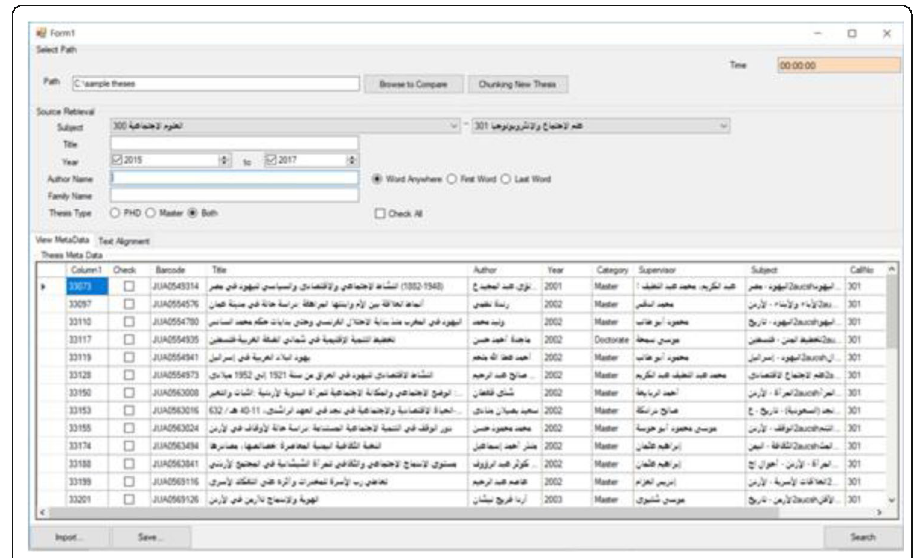
Fig. 5 Graphical user interface of the PD